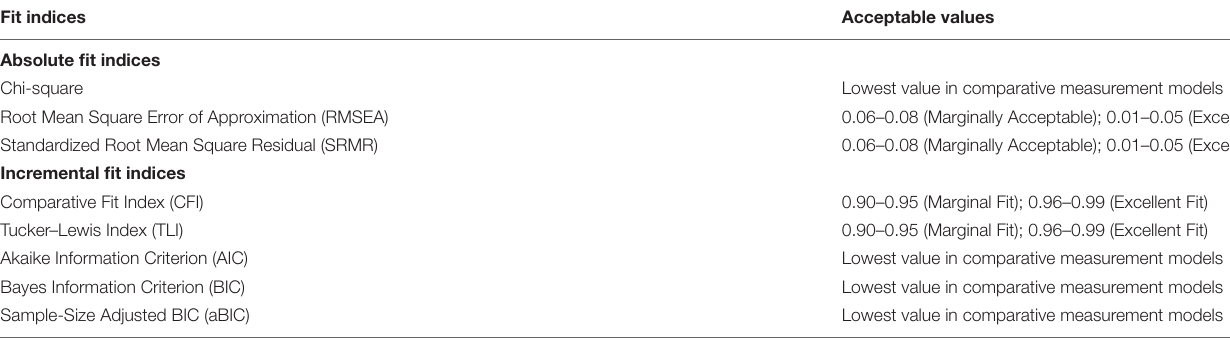
TABLE 2 | Fit indices: acceptable values and cut-off points. Fit indices Acceptable values